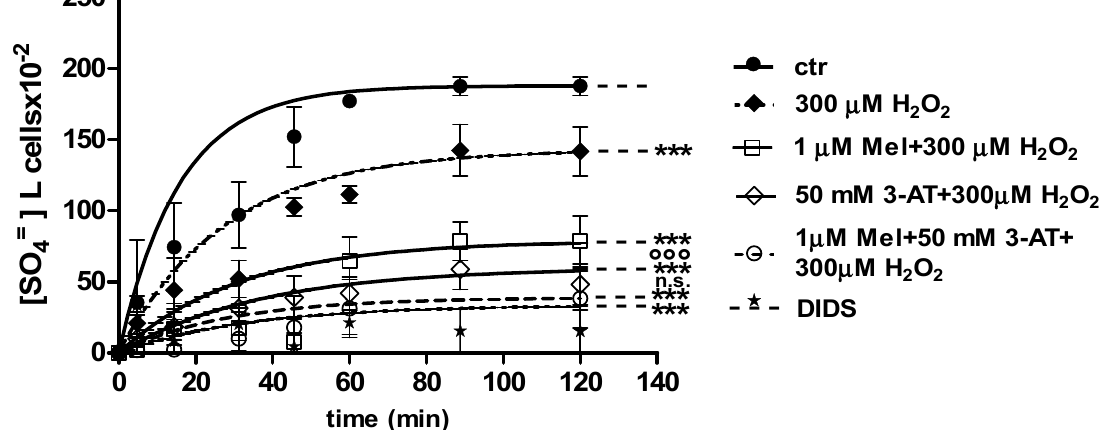
Figure 6. Time course of SO 4 = uptake measured in untreated erythrocytes (ctr) and in erythrocytes treated with 1 μ M Mel + 300 μ M H 2 O 2 with or without pre-exposure to 50 mM 3-AT. *** p < 0.001 vs. ctr; 50 mM 3-AT + 300 μ M H 2 O 2 °°° p < 0.001 vs. 300 μ M H 2 O 2 ; 1 μ M Mel + 50 mM 3-AT + 300 μ M H 2 O 2 n.s. not significant vs. 50 mM 3-AT + 300 μ M H 2 O 2 as determined by one way ANOVA followed by Bonferroni’s post hoc test (N = 8).